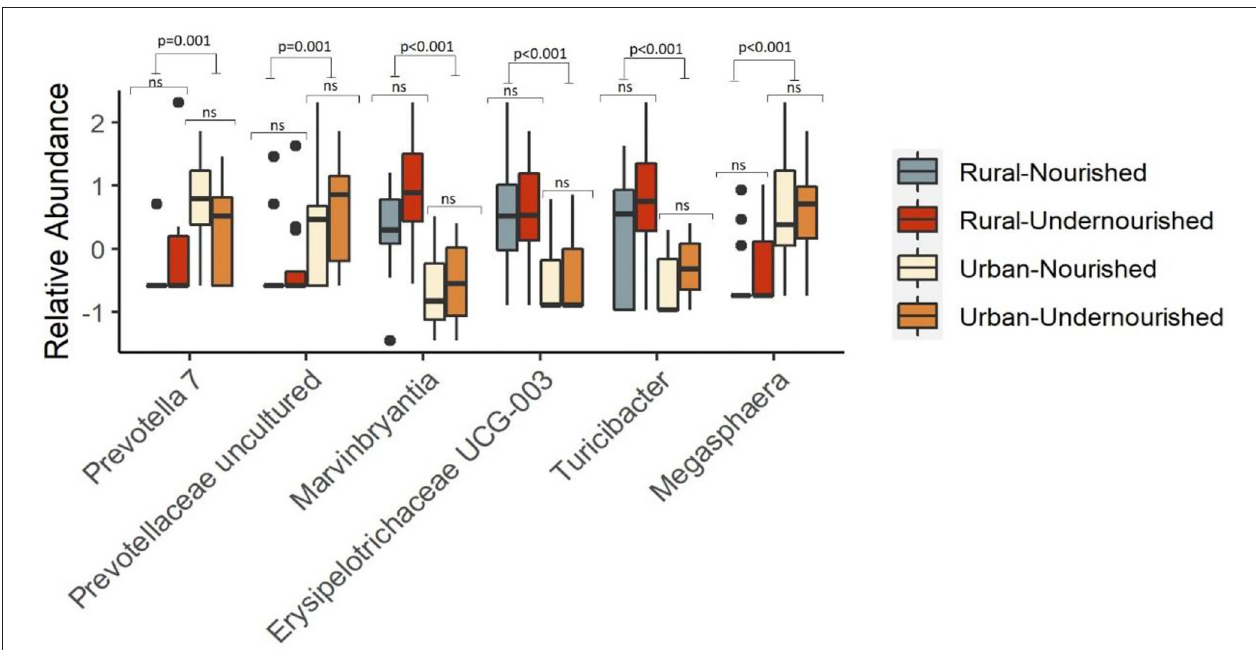
FIGURE 4 | Box and Whisker plot depicting the relative abundance of significant taxa associated with undernourished and nourished from urban slum and rural settings. p -values indicate statistical significance from independent t -tests comparing nourished and undernourished study groups in both the locations (i.e., rural normal vs. rural undernourished and urban normal vs. urban-undernourished) and independent t -test based on location (i.e., rural vs. urban-slum). Box-and-whisker plots show high, low, and median values, with lower and upper edges of each box denoting first and third quartiles, respectively. ns indicates non-significant p -values. Black dots represent the outliers.